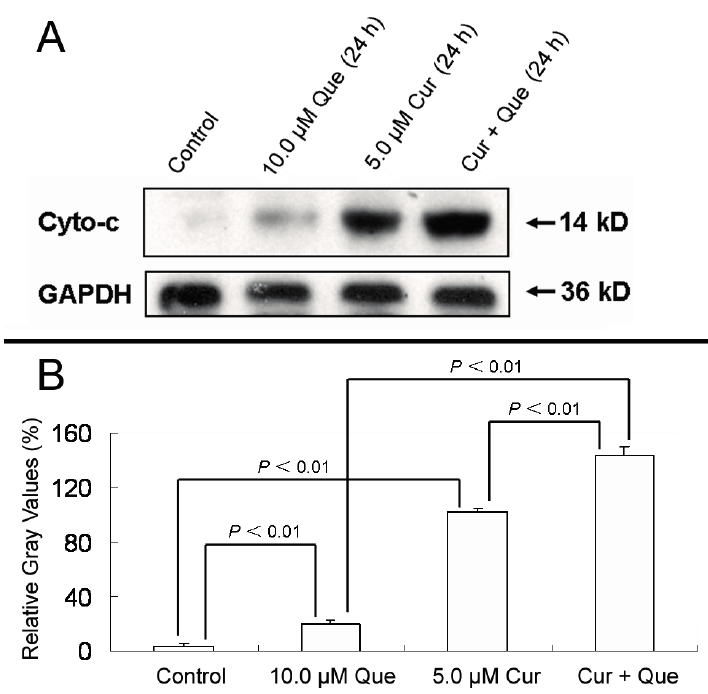
Figure 5. Effect of quercetin and curcumin on cytochrome c release. MGC-803 cells were treated with quercetin (10.0 µM), curcumin (5.0 µM) or a combination of the two for 24 h. The protein expression of cytochrome c was then measured by western blot. ( A ) Expression of cytochrome c in MGC-803 cells. ( B ) Gray intensity analysis of western blot results of ( A ). GAPDH (36 kDa) was used to ensure equal protein loading. Data are expressed as mean ± SD of at least three determinations. p < 0.05 and p < 0.01 represent a significant difference among